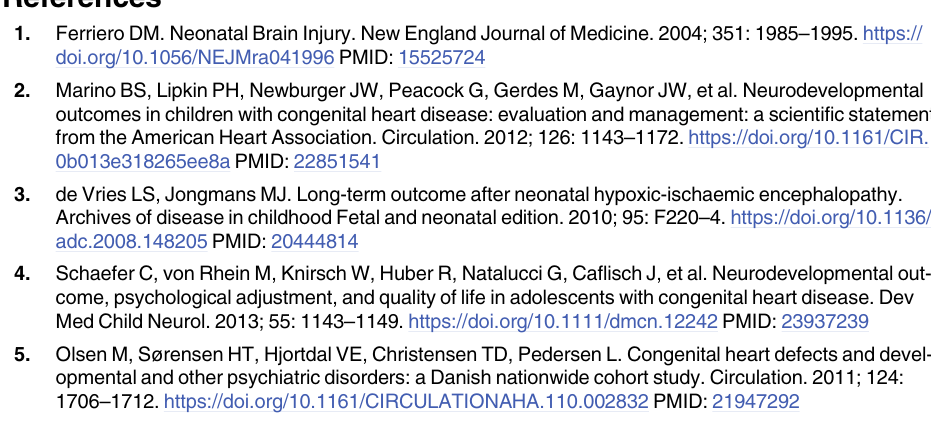
S3 Table. A. Neurodevelopmental outcomes in those with and without injury on MRI. B. Neurodevelopmental outcomes in those with SV and TGA. S4 Table. A. Graphics metrics in those with and without injury on MRI. B. Graphics metrics in single ventricle and transposition of the great